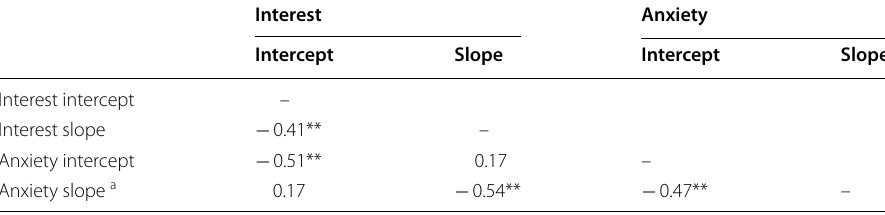
a Slope for T2 to T5 ** p < .01